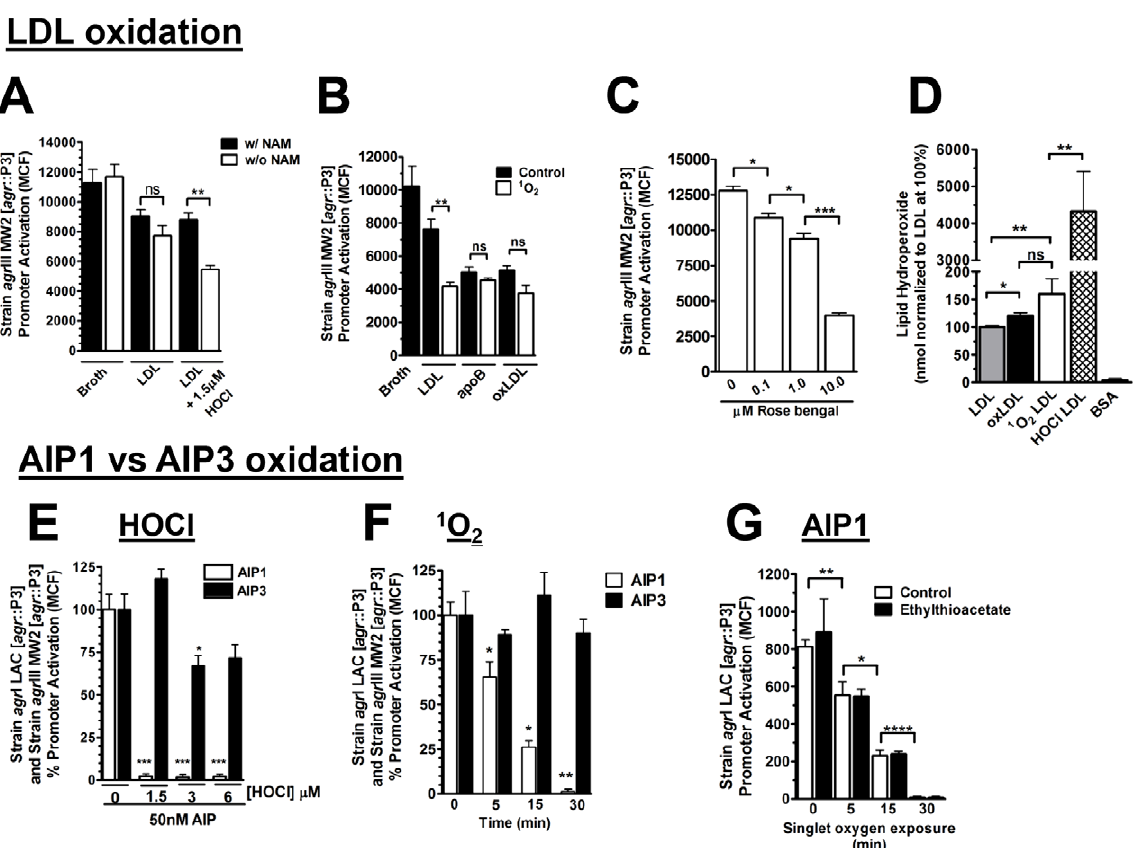
Figure 4. ROS-dependent oxidation of LDL but not of AIP3 mediates antagonism of agr III-dependent quorum sensing. (A, B) LDL, apoB or oxLDL at equimolar concentrations of apoB were treated as shown with (A) HOCl for 30 min at 37 u C, with or without prior addition of the ROS scavenger N-acetylmethionine (NAM), or (B) singlet oxygen (5 min on ice). 10 nM ROS-treated lipoproteins or controls were cultured overnight with agr III MW2 [ agr ::P3-yfp] plus 50 nM AIP. agr :P3 promoter activation was measured by flow cytometry. (C) Strain agr III MW2 [ agr ::P3-yfp] was cultured overnight with 50 nM AIP3 plus LDL treated with increasing concentrations of singlet oxygen. (D) Measurement of LDL lipid oxidation before and after exposure to singlet oxygen or HOCl. Commercially available oxLDL and bovine serum albumin are given as controls. Data represent the mean 6 SEM. (E) AIP1 and AIP3 were incubated with buffer or HOCl for 30 min at 37 u C, treated with NAM to scavenge remaining ROS, and cultured at 50 nM for 2 h with agr I isolate LAC [ agr ::P3-yfp] or agr III MW2 [ agr ::P3-yfp], respectively. Data was measured by flow cytometry. Data points represent the mean 6 SEM normalized to 100% activation by untreated AIP and statistics are in reference to this control. (F) AIP1 and AIP3 were exposed to singlet oxygen by incubation with rose bengal in the presence or absence of light, prior to culture with agr I isolate LAC [ agr ::P3-yfp] or agr III MW2 [ agr ::P3-yfp]. Data points represent the mean 6 SEM normalized to 100% activation by untreated AIP and statistics are in reference to this control. (G) AIP1 was combined with buffer or a 10-fold molar excess of ethylthioacetate prior to exposure to singlet oxygen, followed by culture with agr I isolate LAC [ agr ::P3-yfp]. Data points represent the mean 6 SEM of the mean channel fluorescence. ns, not significant; *, p , 0.05; **, p , 0.01; ***, p , 0.001; ****, p ,